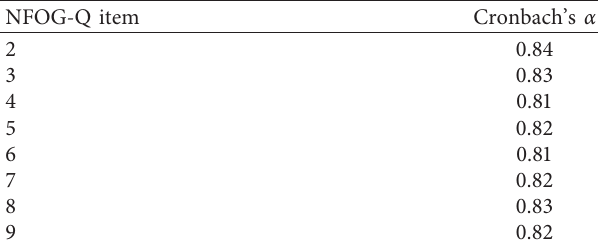
Table 1: Participant characteristics ( n � 57). Table 2: Standardized Cronbach’s α for each ordinal-scale